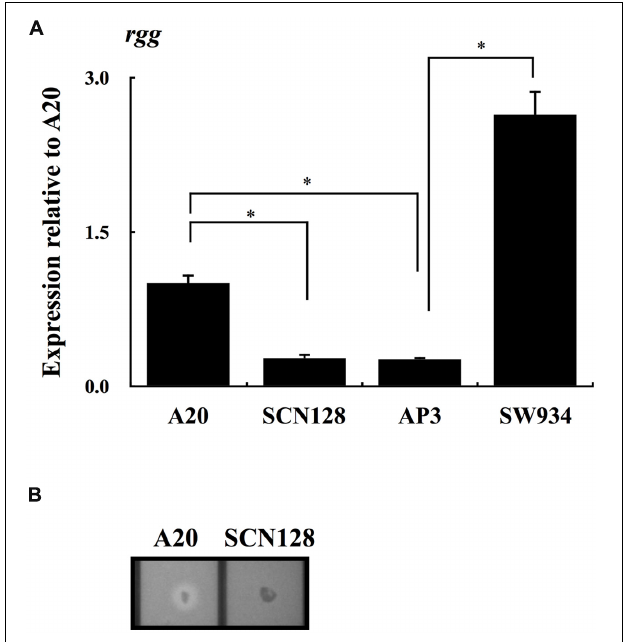
FIGURE 3 | The expression of rgg in A20, A20 CovR D53A mutation strain SCN128, covS mutant AP3, AP3 covR mutant SW934. The expression of rgg in (A) A20, SCN128, AP3, and SW934 in the stationary phase of growth. All qPCR analyses were performed using three independent RNA preparations in duplicate. The expression of rgg was normalized to the gyrA . ∗ p < 0.05. (B) Shows the protease activity of A20 and SCN128. Bacteria were cultured in the 3% skim-milk agar for 12 − 16 h, and the appearance of a clear zone around the bacterial colony is considered protease